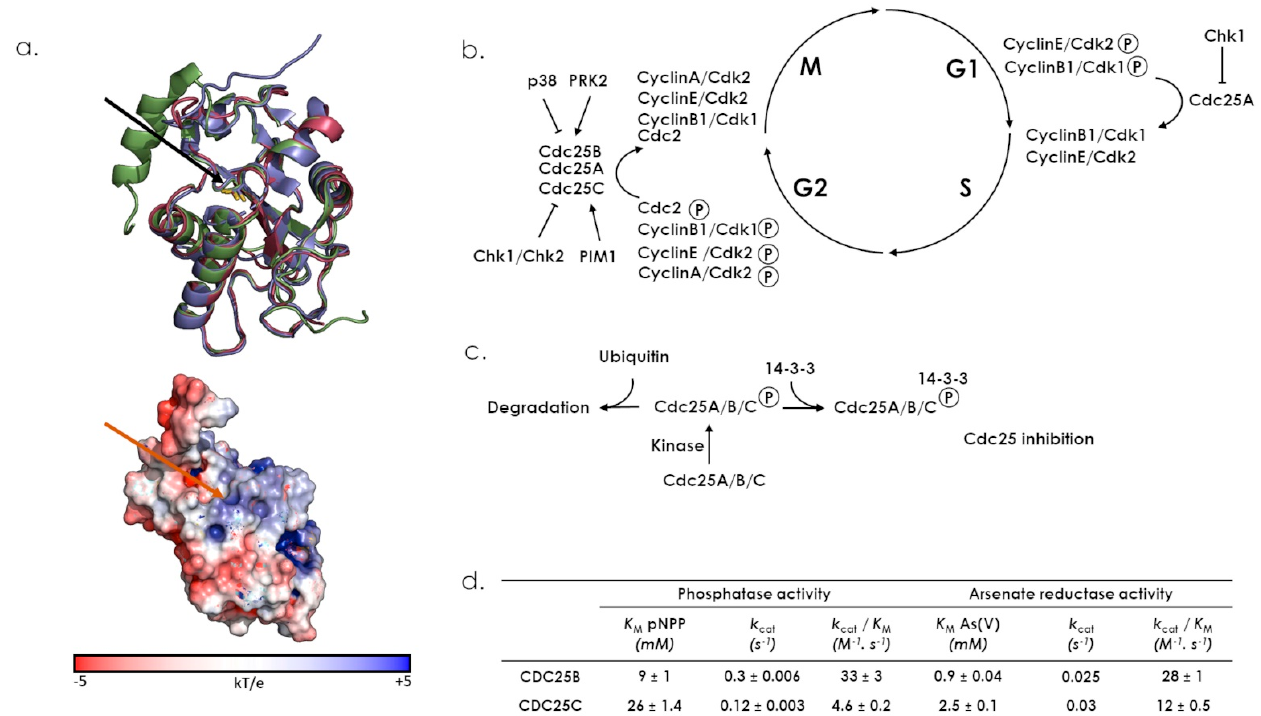
Figure 8. Structural features, catalytic properties and biological functions of CDC25s. ( a ) Upper panel: superimposition of Rhd domains 3D structures from CDC25A (1C25, red), CDC25B (3OP3, purple) and CDC25C (1CWR, green) using Pymol (version 2.4.1). RMSD values: 0.600 Å (1CRW versus 1C25) for 956 remaining atoms; 0.677 Å (1CRW versus 3OP3) for 951 remaining atoms; 0.913 Å (1C25 versus 3OP3) for 959 remaining atoms. Catalytic Cys are represented in sticks and indicated by a black arrow. Lower panel: surface charge representation of 1C25, position of the catalytic Cys is indicated by a red arrow. ( b ) CDC25 phosphatase activities toward Cyclin/Cdk complexes play key roles in cell cycle in regulating both G2/M and G1/S transitions. CDC25 activities are enhanced or inhibited by various kinases activities at different cell cycle phases. ( c ) CDC25 activities are also regulated by 14-3-3 reversible inhibition or proteasome activity. ( d ) Kinetic parameters of the phosphatase and arsenate reductase activities of purified Rhd domains of CDC25s [17]. Phosphatase activity was obtained from the rate of hydrolysis of p-nitrophenyl phosphate (pNPP), and arsenate reductase activity was determined using a coupled assay combining GSH, glutathione reductase, NADPH and